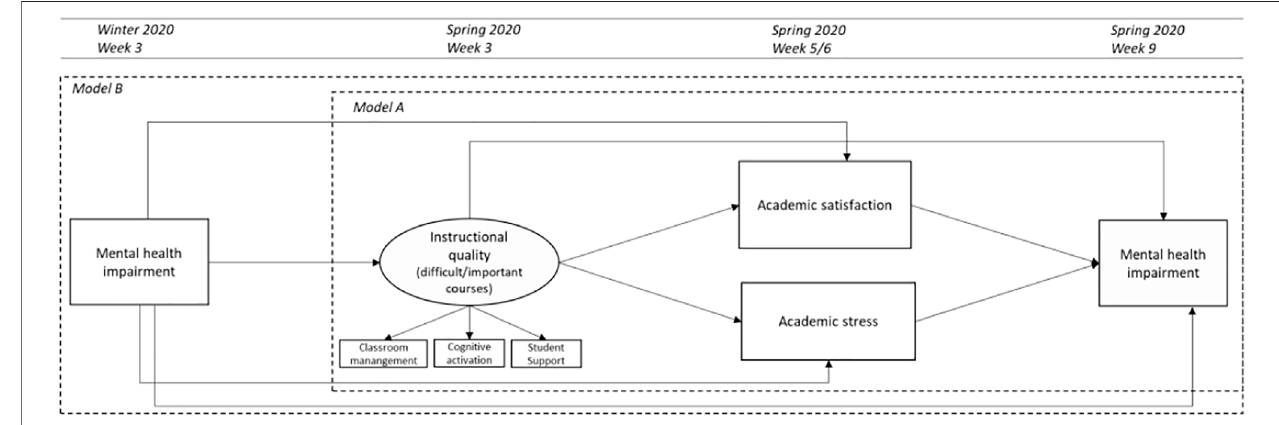
FIGURE 1 | Theoretical tested